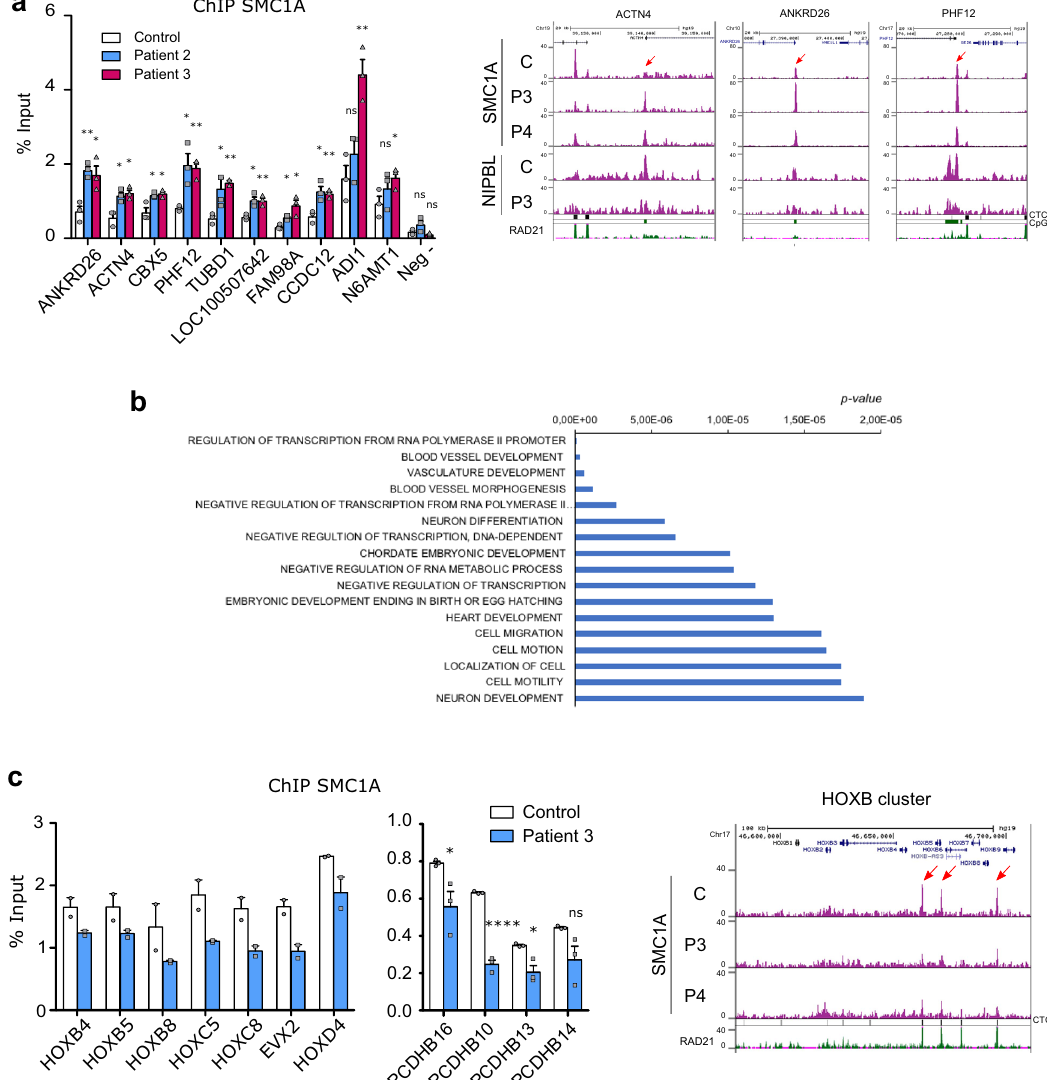
Fig. 6 Validation of the differential SMC1A peaks by ChIP-qPCR experiments. a Cells from a control (white) and two CdLS patients (P2, blue; P3 purple) were used in ChIP-qPCR experiments to validate the SMC1A ChIP-Seq data using primers at the indicated genes. An intergenic region was used as a negative control (Neg − ). Means and SEMs were calculated from biological triplicates (left). Two-sided unpaired student ’ s t -test (** p < 0.01; * p < 0.05). Sna p shots of SMC1A and NIPBL peak distributions in control (C) and CdLS patient cells (P3 – 4) at three validated genome regions (right). The red arrows indicate the validated SMC1A peaks. b Gene ontology (GO) analysis reveals enriched biological processes in the SMC1A differential genomic positions in CdLS-derived fi broblasts. c ChIP-qPCR experiments were performed to validate the SMC1A ChIP-Seq data at three regions of HOXB, two of HOXC, two of HOXD, and four regions of the PCDHB clusters using cells from a control (white) and a CdLS patient (blue). Means and SEMs were calculated from biological duplicates (HOX) and triplicates (PCDHB). Two-sided unpaired student ’ s t -test (**** p < 0.0001; * p < 0.05) (left). Snapshots of SMC1A peak distributions in control (C) and CdLS patient cells (P3 – 4) for the HOXB cluster (right). Red arrows indicate three validated SMC1A peaks within the HOXB